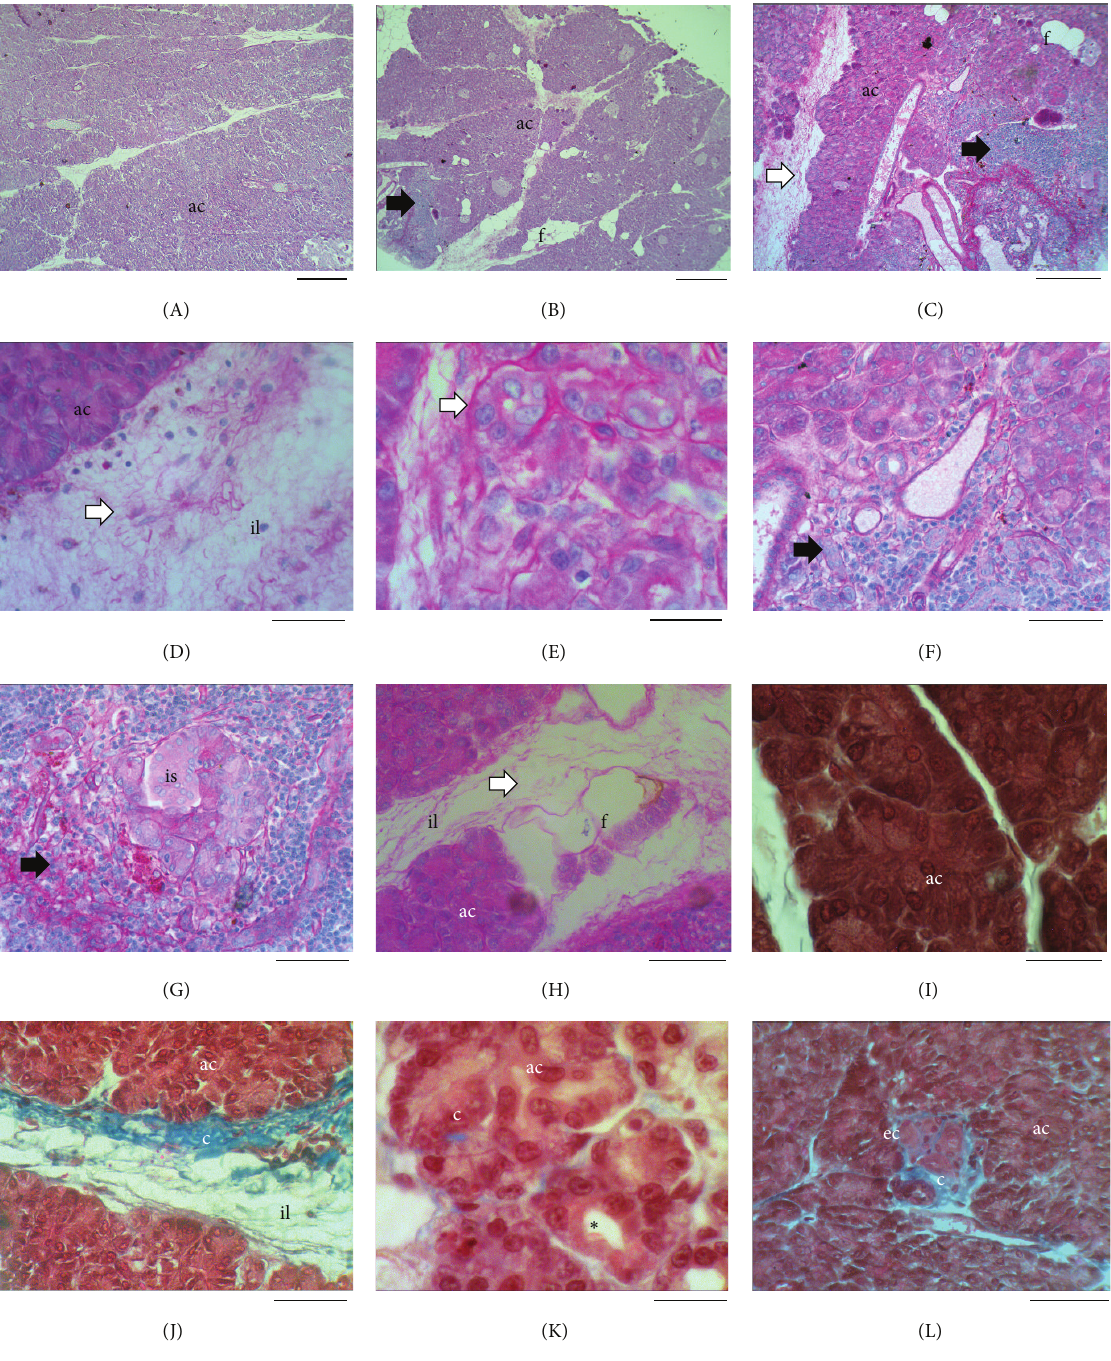
Figure 1: Histological characteristics of the pancreas from control and hypothyroid female rabbits. Pictures of pancreas from control ((A) and (I)) and hypothyroid ((B)–(H) and (J)–(L)) females, showing the presence of proteoglycans ((C)–(H)) as a component of the extracellular matrix, the infiltration of immune cells ((B)–(G)), and the presence of collagen ((I)–(L)). Bar: (A)-(B) = 200 𝜇 m; (C) = 100 𝜇 m; (D), (F)–(H), (J), and (L) = 50 𝜇 m; and (E), (I), and (K) = 20 𝜇 m. ac: acinar cells; is: islets; il: interlobular septa; c: collagen; f: fat; ec: stellate cells. Black arrow: immune cells infiltration; white arrow: proteoglycans; asterisk: